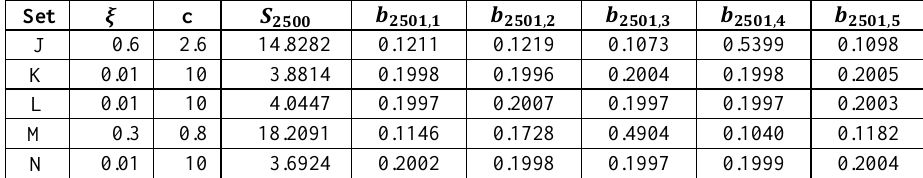
Table 2. The wealth 𝑆 2500 and the final portfolios obtained by running the universal portfolio (13) for selected values 𝜉 and 𝑐 on the data sets J, K, L, M and